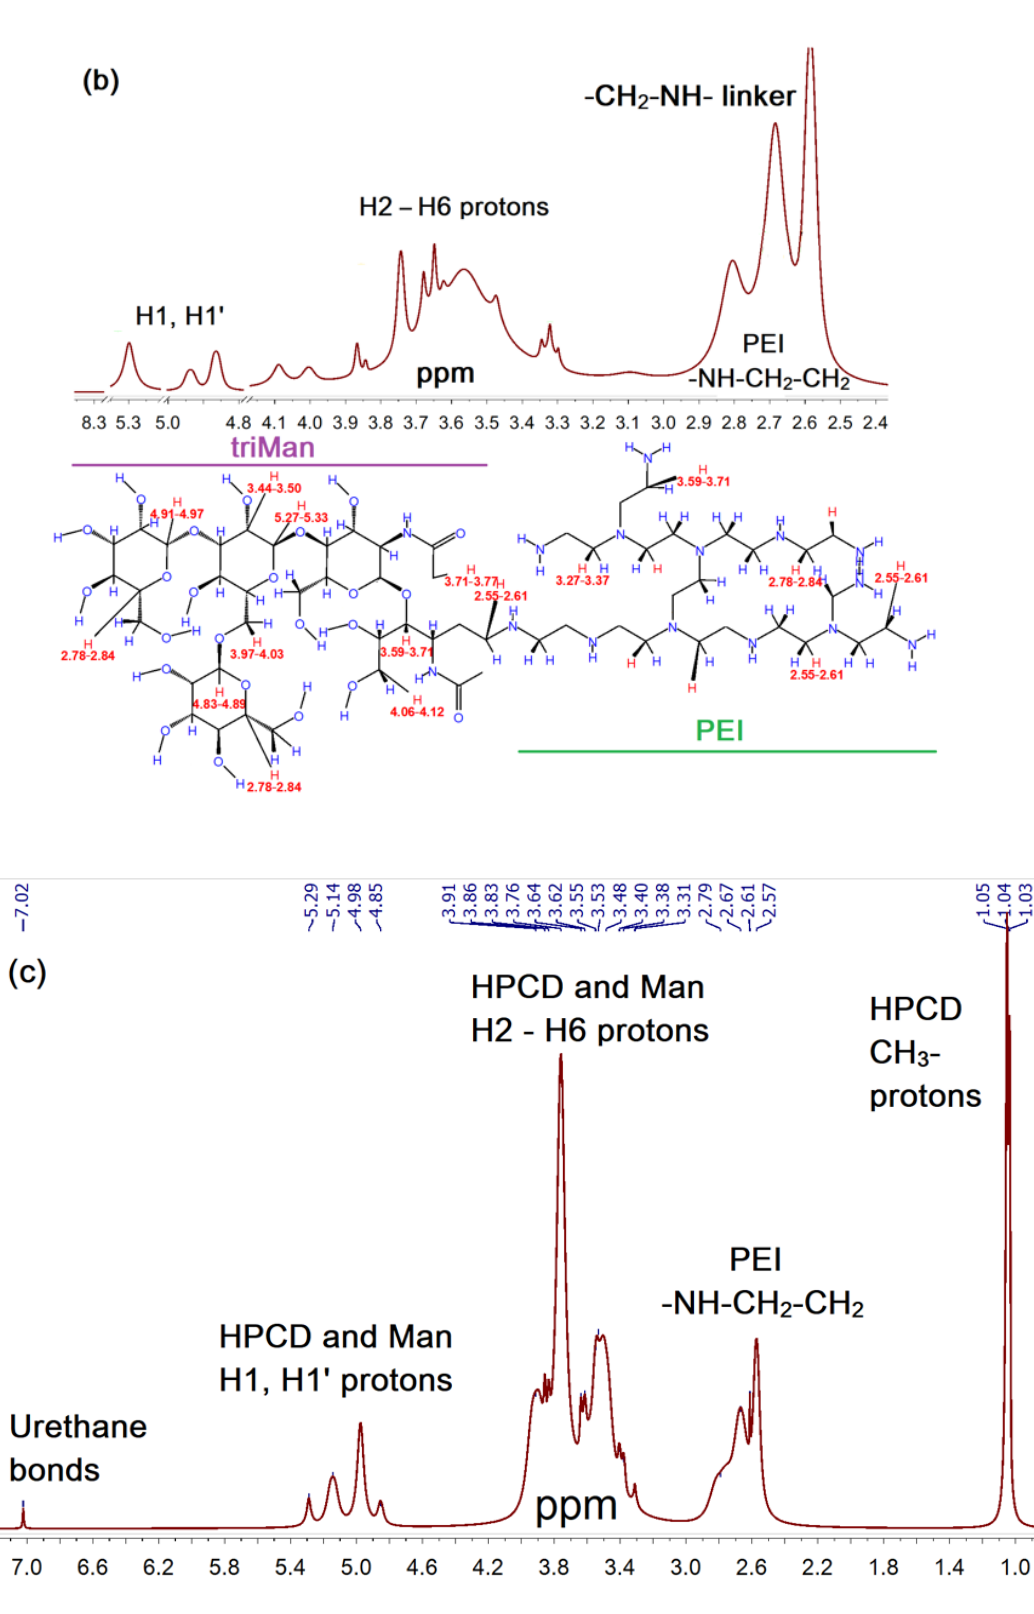
Figure 3. 1 H NMR spectra of ( a ) triMan-GlcNAc 2 , ( b ) PEI1.8-triMan, and ( c ) HPCD-PEI1.8-triMan with proton assignment. D 2 O, 400